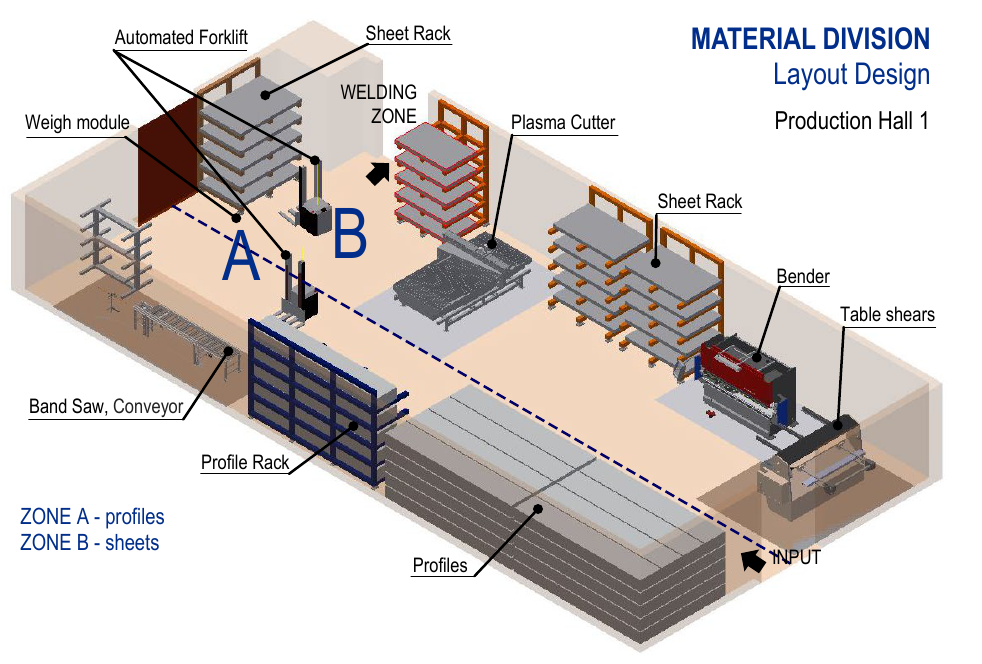
Figure 4. Storage and preparation of